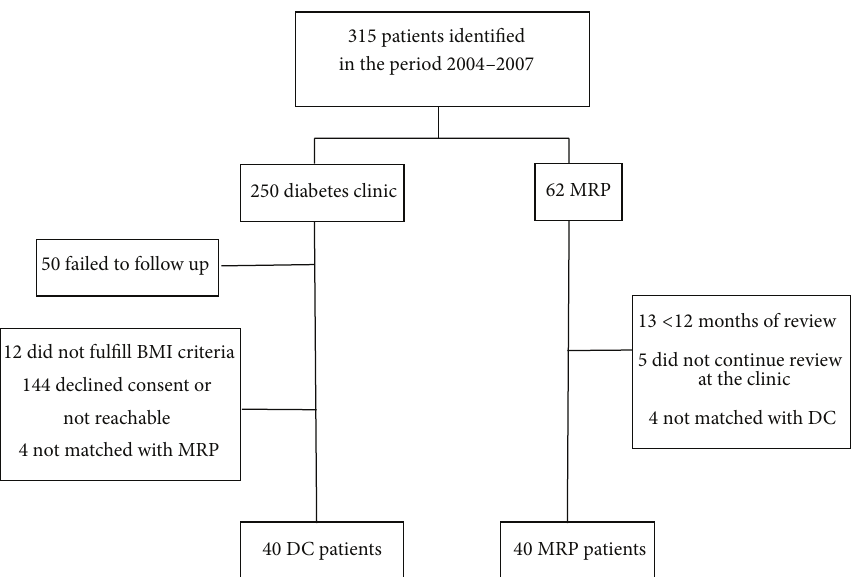
Figure 1: Study participants selection and